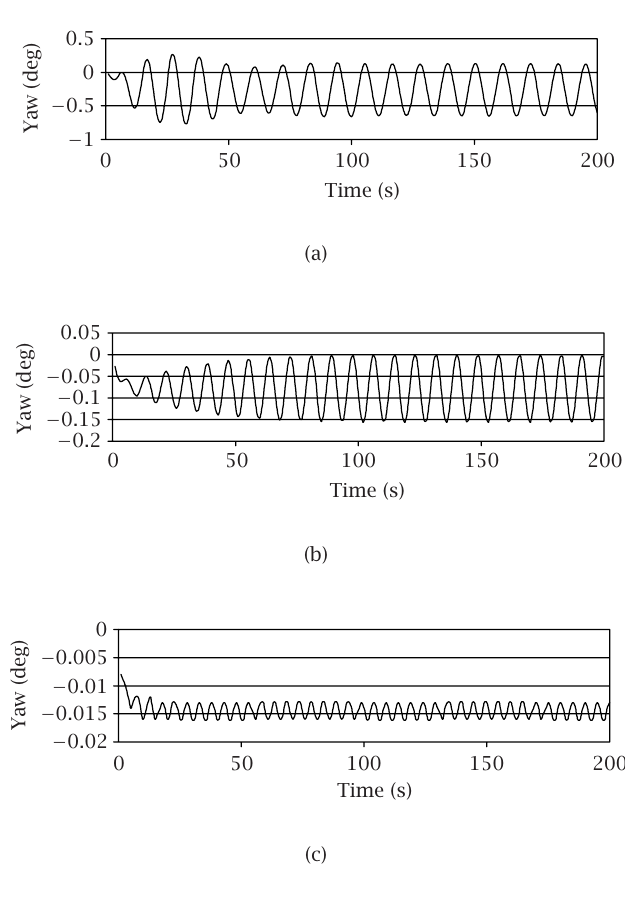
Figure 7.3 . Time history of yaw motion for wave frequencies: (a) 0.56rad/s, (b) 0.74rad/s, and (c)